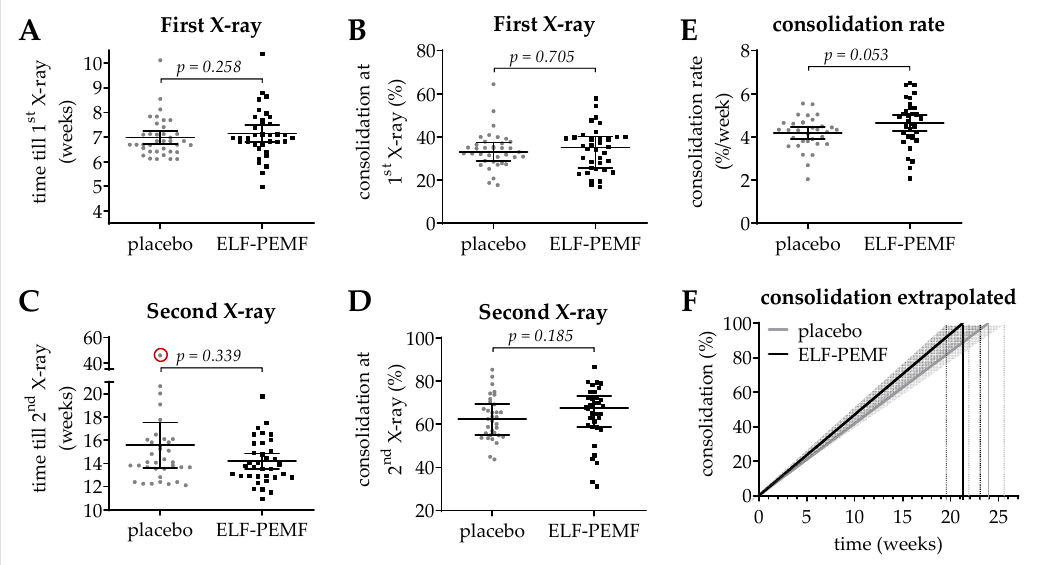
Figure 3. Osseous consolidation in the study cohort. ( A , C ) show the time from surgery till first (1st) or till second (2nd) X-ray, respectively. ( B , D ) show the osseous consolidation at the 1st and 2nd X-ray, respectively. Osseous consolidation is given in %. ( E ) The consolidation rate was determined as: Δ osseous consolidation (2nd X-ray—1st X-ray)/Δ time (2nd X-ray—1st X-ray). Data are represented as scatter diagrams (mean ± 95% CI). ( F ) Extrapolation of the resulting mean (line) ± SEM (surrounding area) consolidation rates of the ELF-PEMF and placebo group. Two-tailed Mann–Whitney U -test was used to determine p -values. N = 34 per group (geometric mean of n = 3).